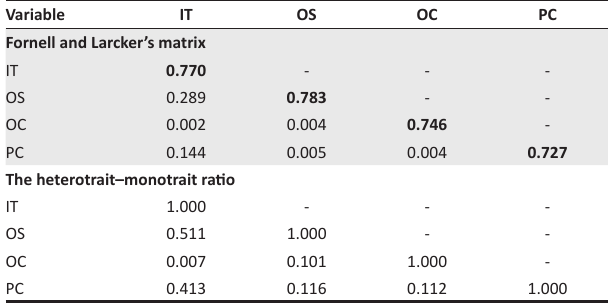
TABLE 1 : Construct measurement summary. Construct TABLE 2 : Discriminant validity.